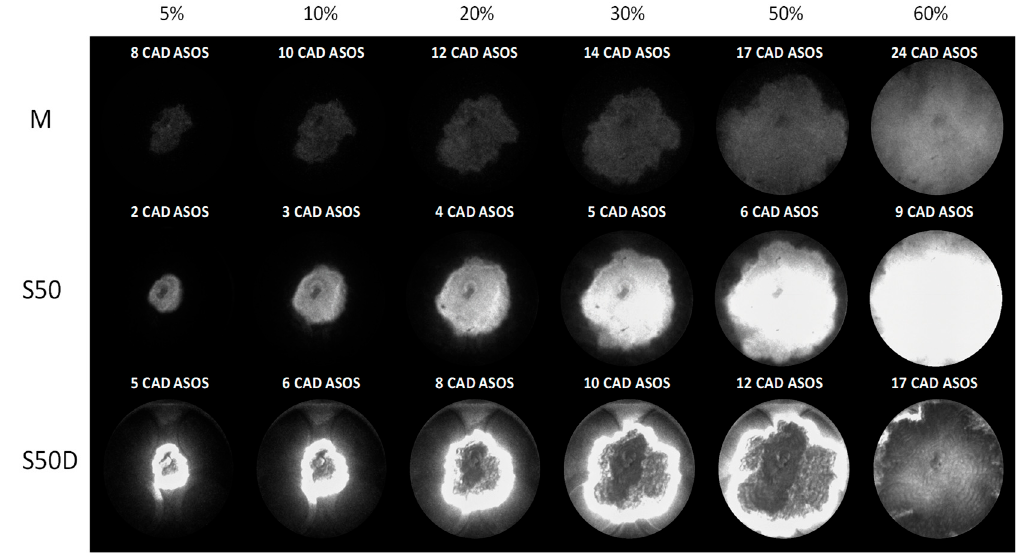
Figure 10. Image sequence of flame evolution at the same flame area (5%, 10%, 20%, 30%, 50% and 60% of the piston cross-section) for a stoichiometric air-fuel ratio ( λ = 1.0) with M, S50, and S50D fuelling.